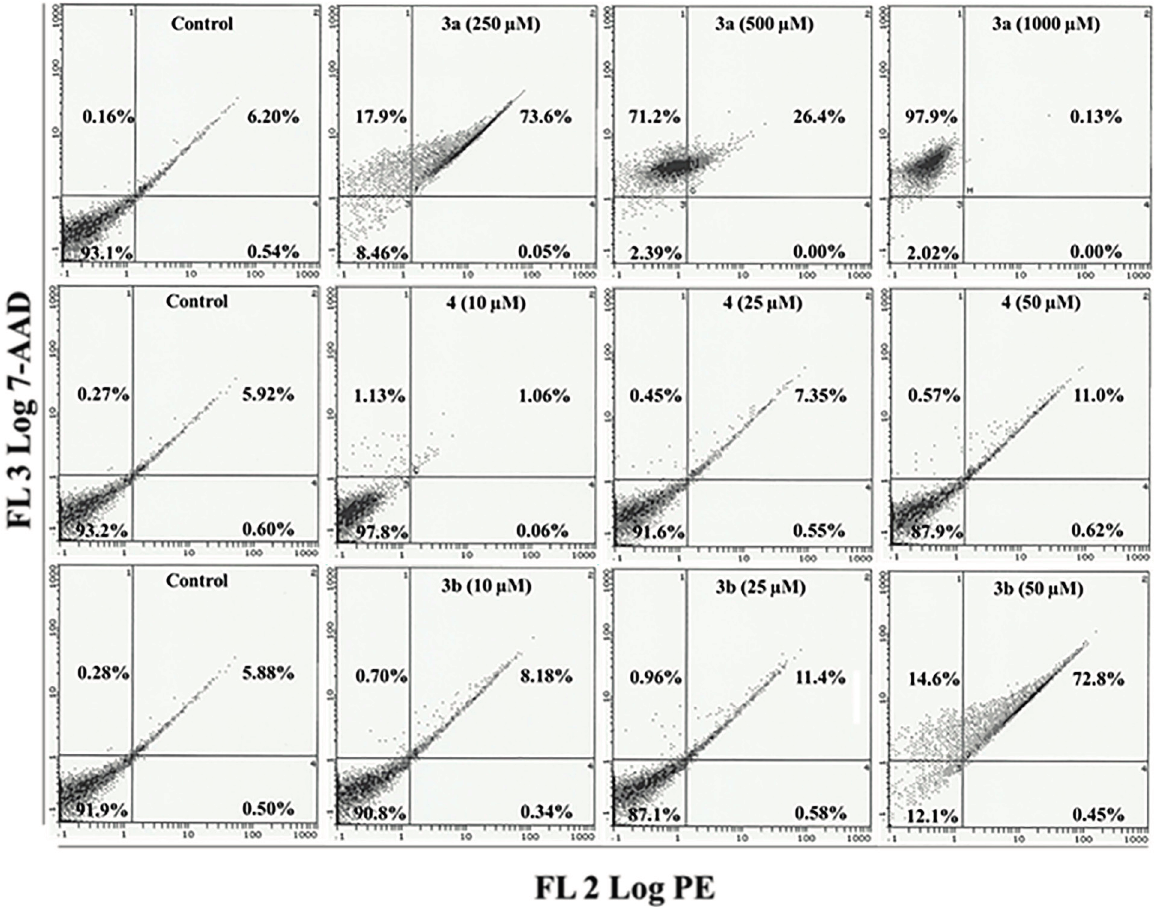
Figure 6. Annexin V-PE (phycoerythrin) and 7-AAD (7-aminoactinomycin D) assay following treatment of HepG2 cells. Bivariate flow cytometry analysis of HepG2 cells treated with compounds 3a , 3b and 4 . Early apoptotic, late apoptotic and necrotic